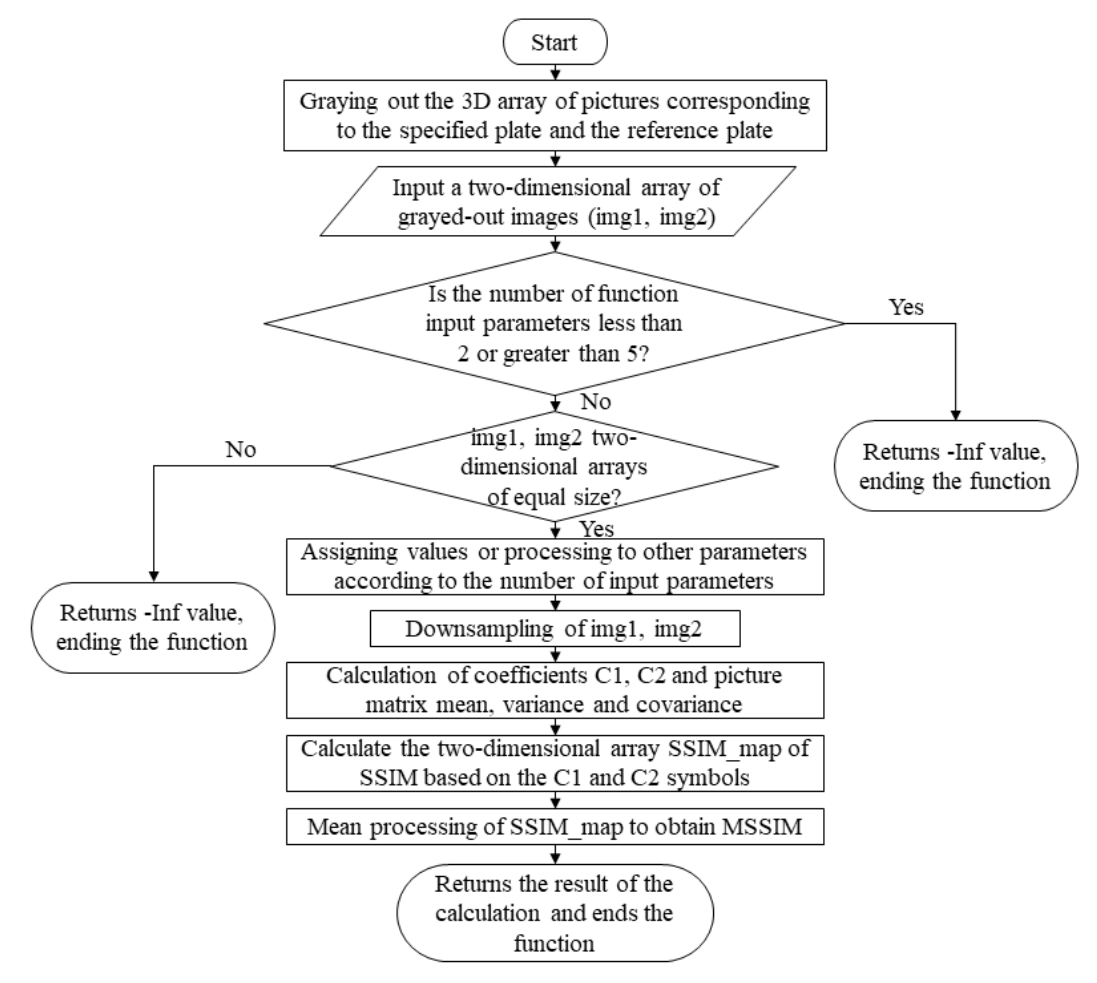
Figure 3. Compilation framework for the grayscale SSIM algorithm.